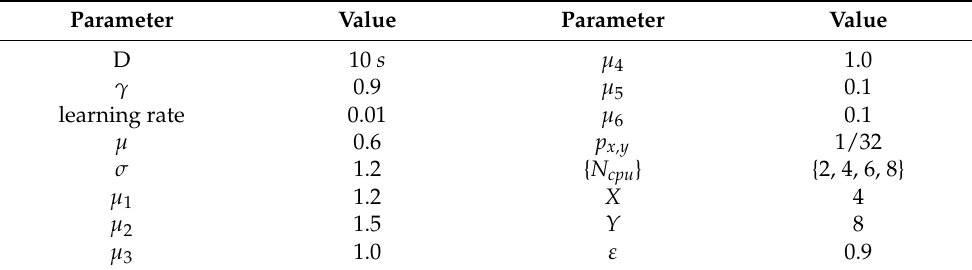
Table 1. Summary of major parameters’